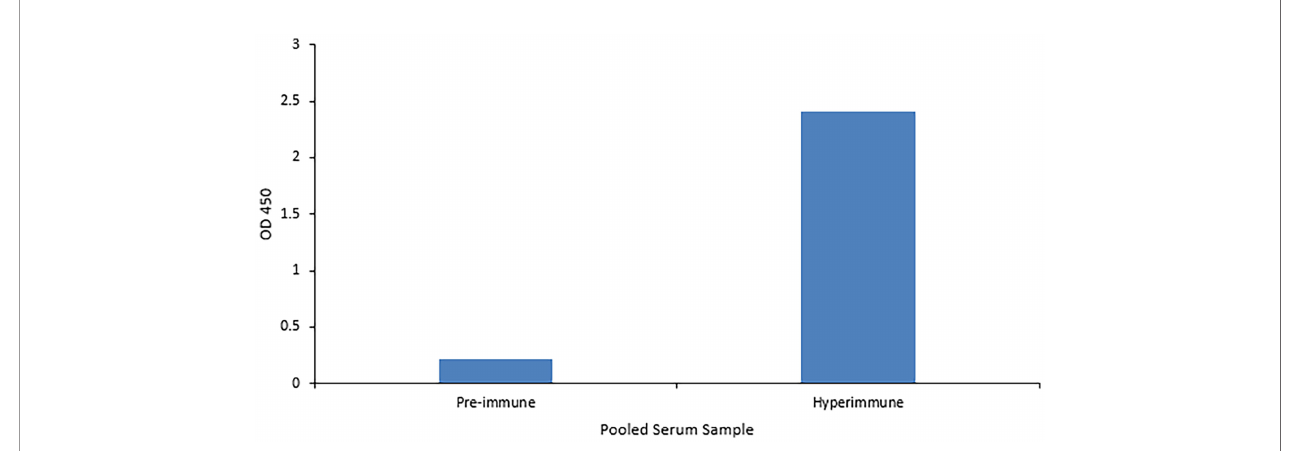
FIGURE 2 | Anti-VP8 chicken antiserum detects recombinant VP8 in an ELISA. Indirect ELISA comparing the af fi nity of pooled pre- and hyper-immune serum antibodies for the recombinant VP8 antigen. Birds received three immunizations consisting of 50µg puri fi ed VP8 with Montanide as an adjuvant. An ELISA plate was coated overnight with 5µg/ml puri fi ed HRV VP8 and blocked with 2% BSA in PBS. The pre- and hyper-immune anti-VP8 serum antibodies served as the primary antibody (1:1,000). HRP-conjugated goat anti-chicken IgY was added as the secondary antibody (1:3,000). The hyperimmune serum was speci fi c for the viral protein.